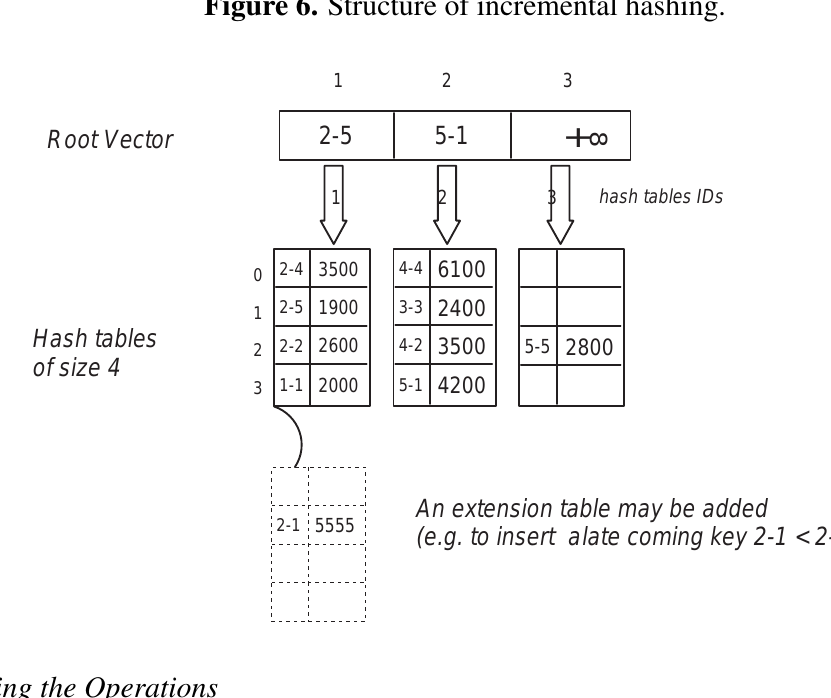
Figure 6. Structure of incremental